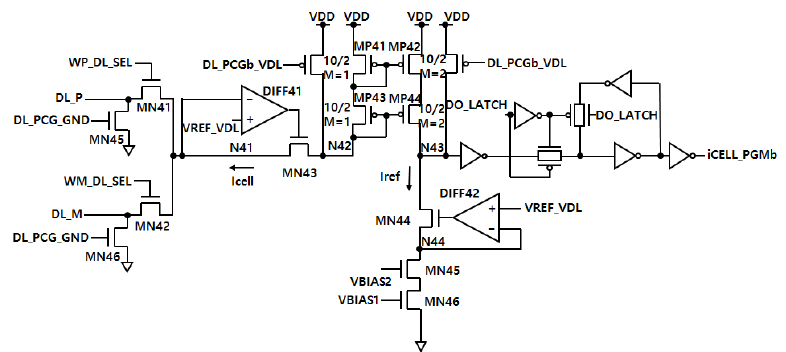
Figure 12. Current sensing circuit.